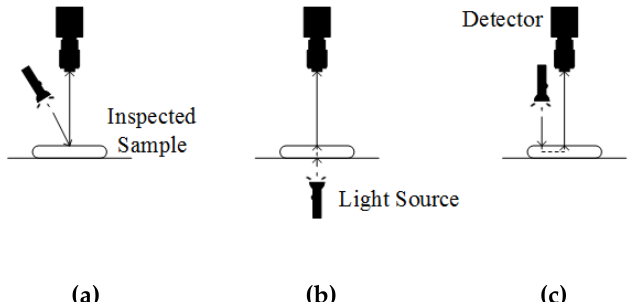
Figure 6. Sensing modes in spectral imaging; ( a ) reflectance, ( b ) transmittance, and ( c ) Interactance [36]. Reproduced with permission from D. Wu, Innovative Food Science & Emerging Technologies, Published by Elsevier, 2013.